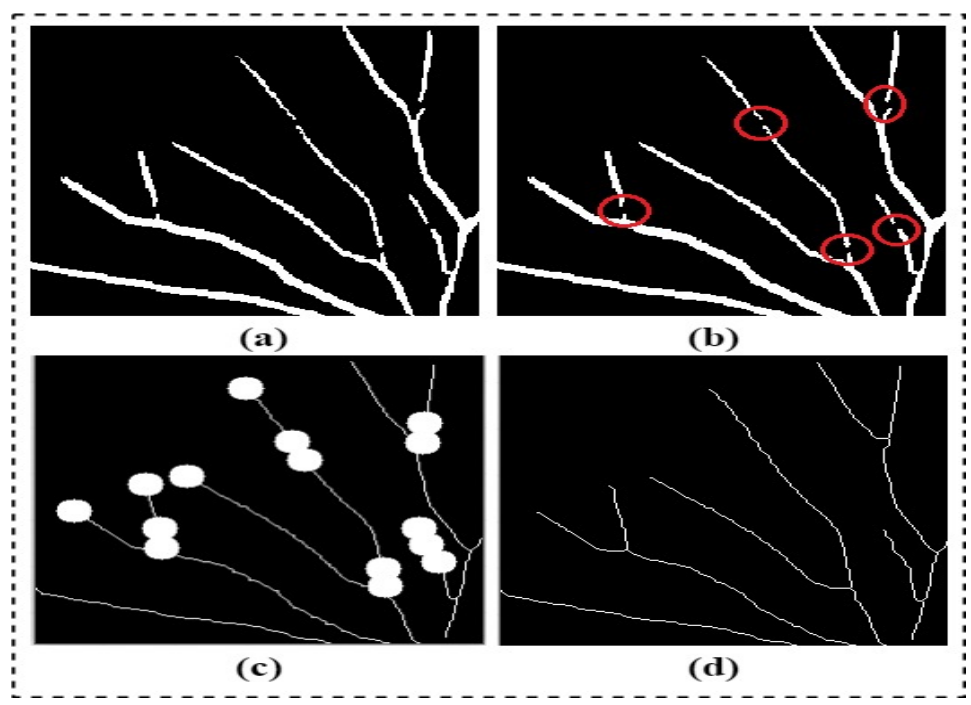
Figure 6. The proposed blood vessel linking procedure: ( a ) the segmented blood vessel structures; ( b ) the disconnected blood vessels marked in the red circles; ( c ) the binary circular-shaped structural elements are drawn at the ends of each blood vessel segment; and ( d ) the resulting image with linked blood vessels.